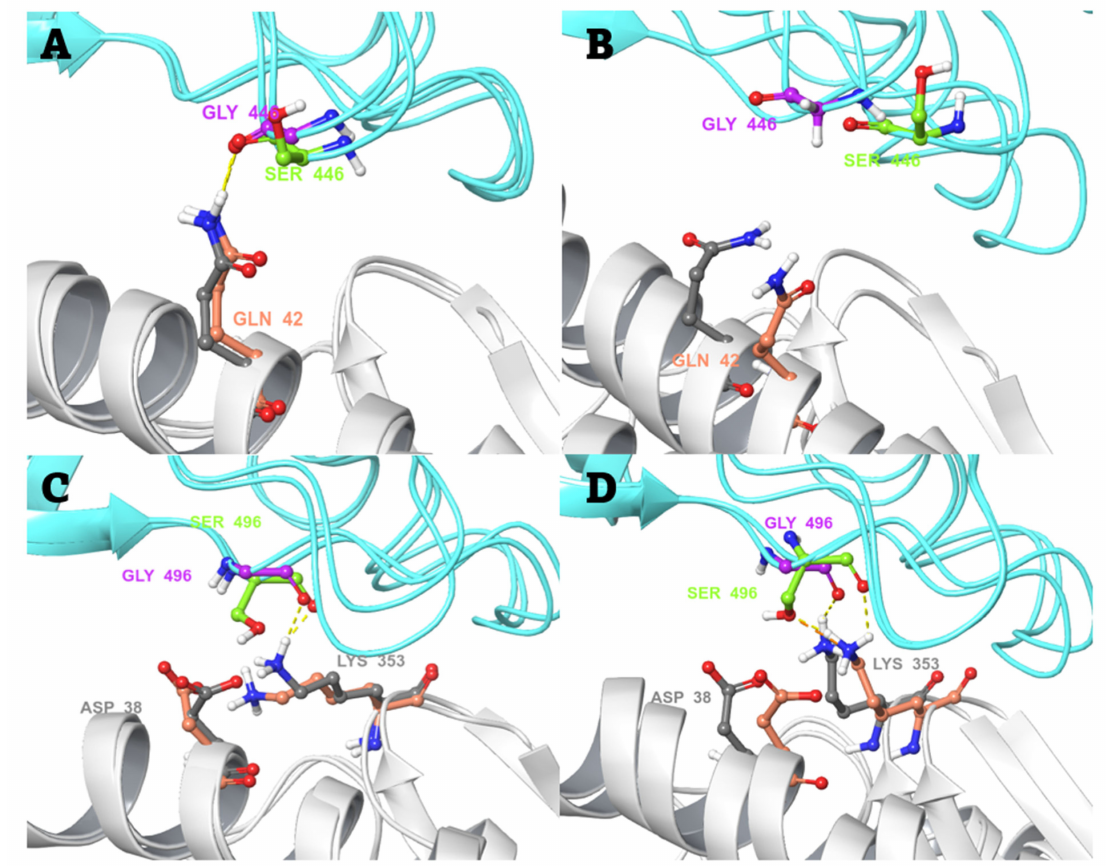
Figure 3. The change in local environment at the binding interface of SARS-CoV-2 spike RBD and hACE2 is caused by single-residue mutations. The orientation and interactions of Gly446 of WT spike RBD and Ser446 of the mutant, with respect to Gln42 of hACE2 ( A ) before the start of production MD simulation, and ( B ) after a 200-ns MD simulation. The orientation and interactions of Gly496 of spike RBD WT and Ser496 of the mutant, with respect to Asp38 and Lys353 of hACE2 ( C ) before the start of production MD simulation, and ( D ) after a 200-ns MD simulation. Colour scheme: spike RBD and hACE2 in cyan and white colour cartoon, respectively. Spike RBD and hACE2 amino acid residues in pink/grey (WT complex) and green/salmon (mutant complex) elemental ball and sticks representation, respectively. Interactions are shown in dashed lines: yellow—H-bonds; orange—bad